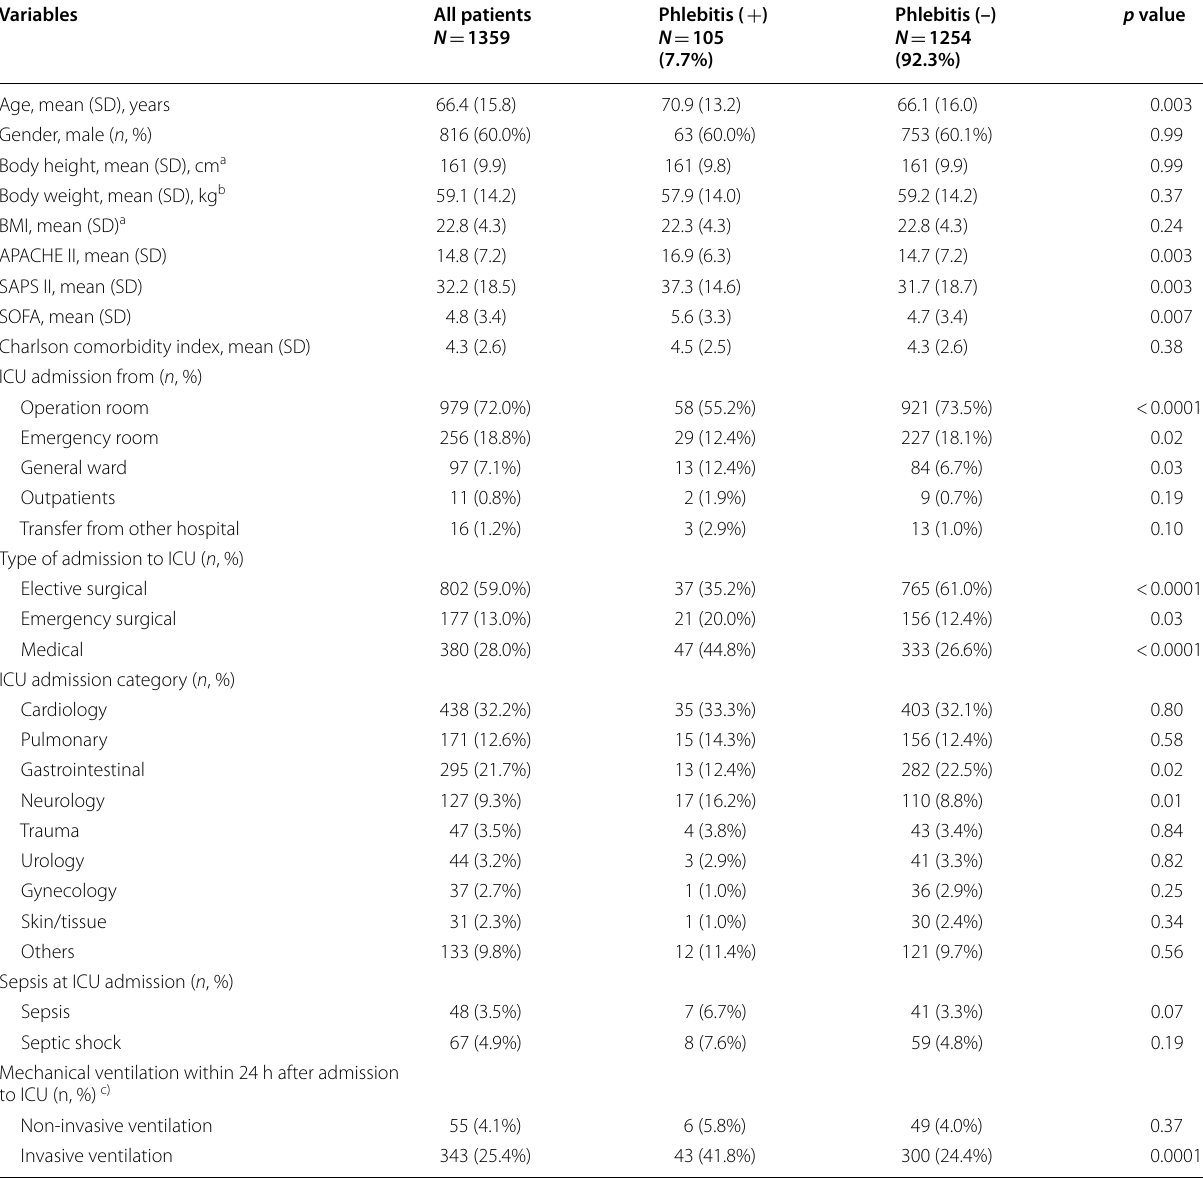
Table 1 Patient characteristics at ICU admission with or without